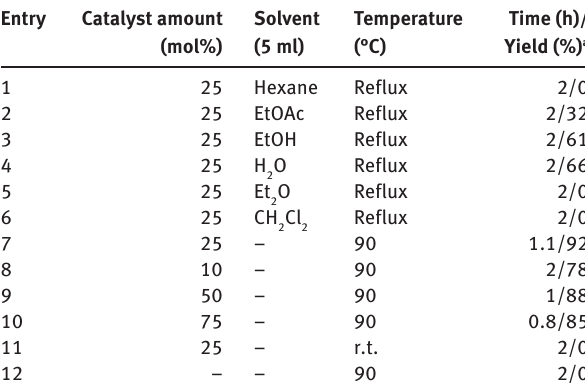
Table 1: Optimization of the reaction conditions.